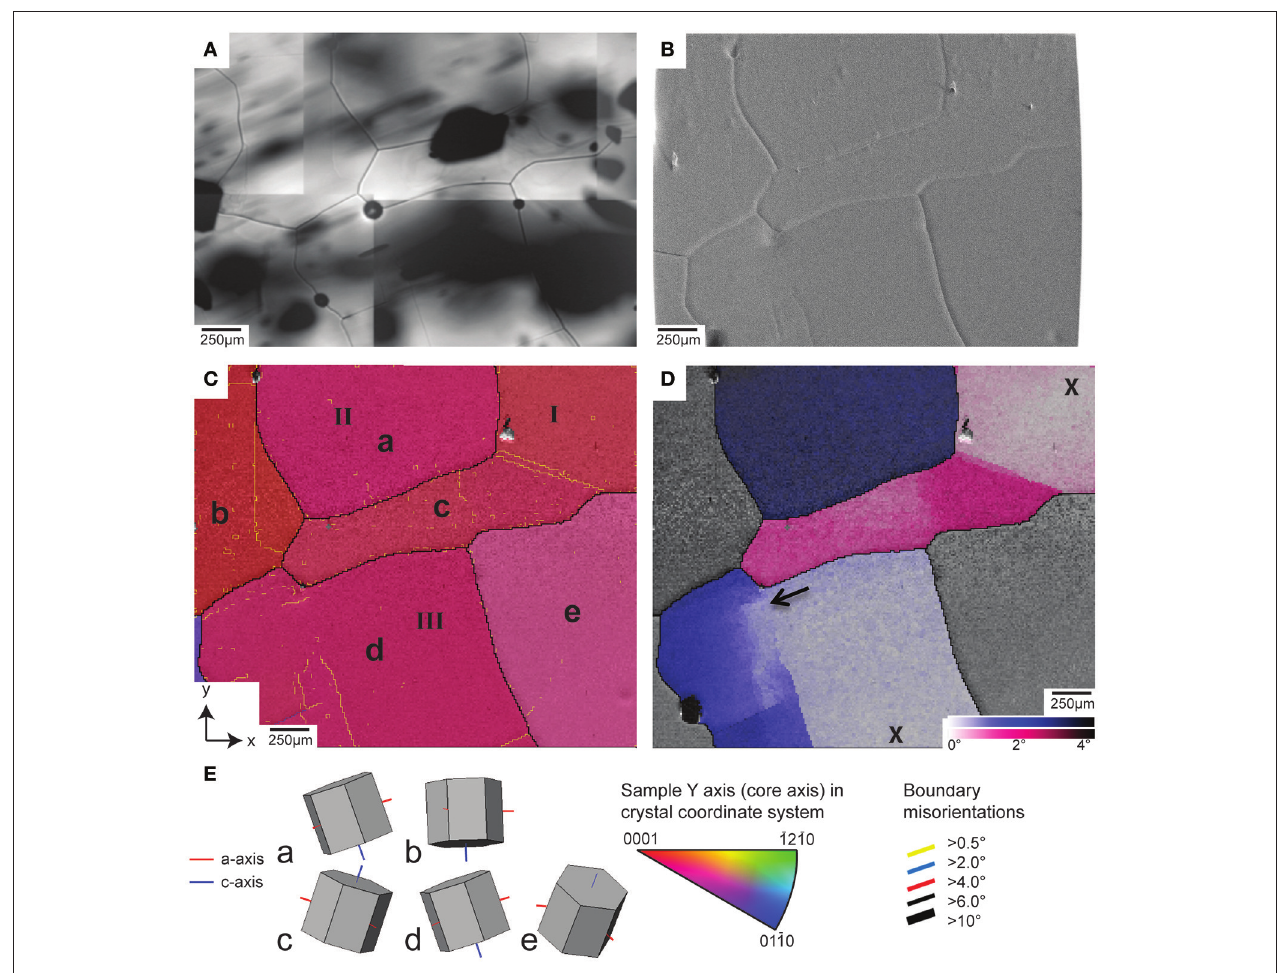
FIGURE 8 | Optical-microscopy, SEM and EBSD maps of an ice core sample at 442.7m depth in the NEEM ice core. (A) Part of the optical-microscopy image taken just after sample preparation. (B) SEM image of the mapped part of the EBSD sample. The curved edges are a result of the beam being blocked by the electron column. (C) EBSD map, with the y-axis parallel to the (vertical) core axis. (D) Map showing the orientation difference of up to 4 ◦ relative to the two spots marked with “X.” (E) Schematic illustration of measured full CPO (c- and a-axes) at positions (a–e), and color codes for CPO and boundary